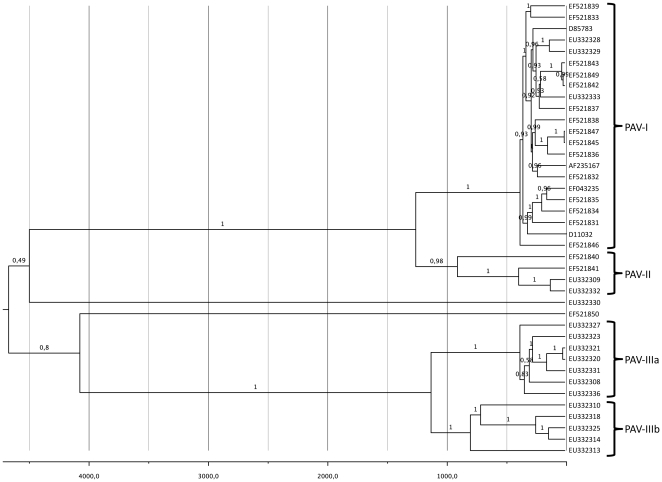
MCC phylogeny of 40 non-recombinant BYDV-PAV isolates.The tree was calculated from the posterior distribution of trees generated by Bayesian MCMC coalescent analysis with BEAST [32]. Posterior probabilities are indicated above branches.